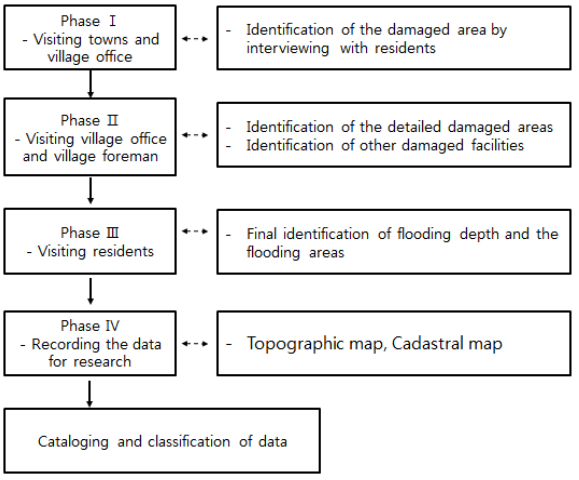
Figure 2. Flowchart of the flooding area investigation Figure 3 describes the inner part of flooded houes. Through